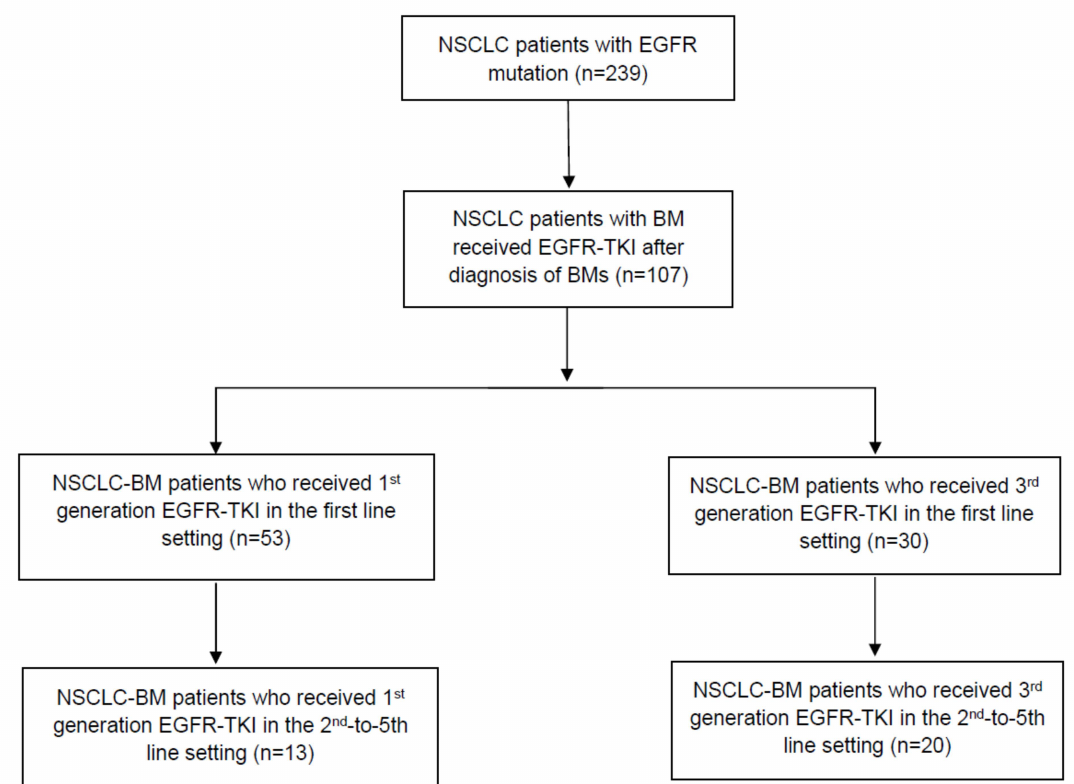
Figure 1. Flow diagram of the current